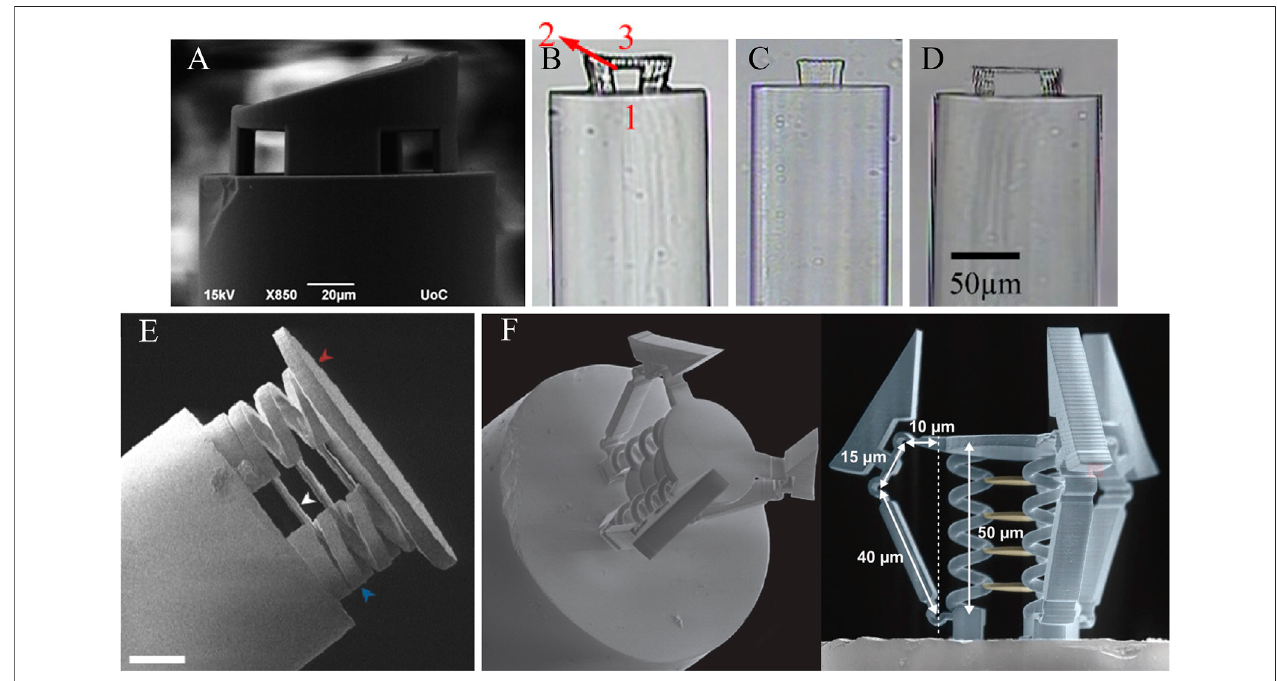
FIGURE 5 | Optical fi ber integrated FPIs printed by TPP. (A) Open cavity FPI for vapor sensing (Melissinaki et al., 2015). (B) Open cavity FPI for simultaneous measurementofliquidRIandtemperature(Lietal.,2015). (C) Liquidpolymer fi lledFPIwithsealedcavityfortemperaturesensing(Lietal.,2016a). (D) OpencavityFPIfor acoustic sensing (Li et al., 2017a). (E) Microscale fi ber force sensor (Thompson et al., 2018). (F) Force-sensitive microgripper (Power et al.,